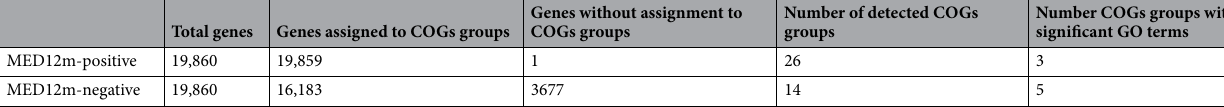
Table 1. COGs groups detected by WGCNA and the numbers of COGs groups with significant KEGG pathways and GO terms.